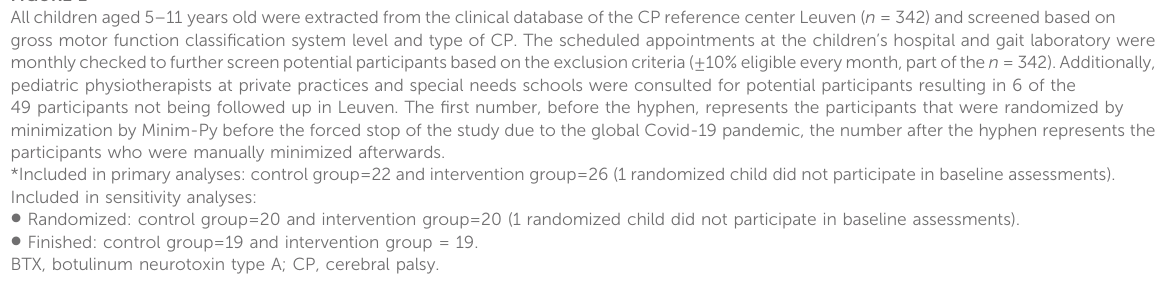
limb score was 7.1 ± 2.6. For the intervention group ( n = 26) the average age was 8.3 ± 2.0 years, with an average weight of 27.7 ± 8.1 kg and 127.3 ± 14.0 cm. Seventeen children were classi fi ed as GMFCS level I, 5 as GMFCS level II and 4 as GMFCS level 3. Eleven children were unilaterally affected and 15 bilaterally, resulting in 41 assessed legs. Fibula length was on average 27.3 ± 3.6 cm and the selective control assessment of the lower limb score was 7.0 ± 2.1. One participant was randomized but never assessed due to repeated cancellations, therefore the total number of participants in the primary analyses is 48 (n participants = 48, n affected legs = 77).